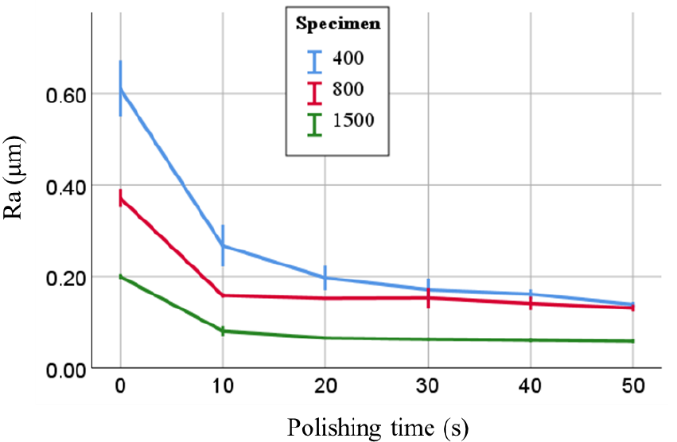
Figure 2. Changes in mean surface roughness with polishing times and specimen types. Error bar indicates ±SD.